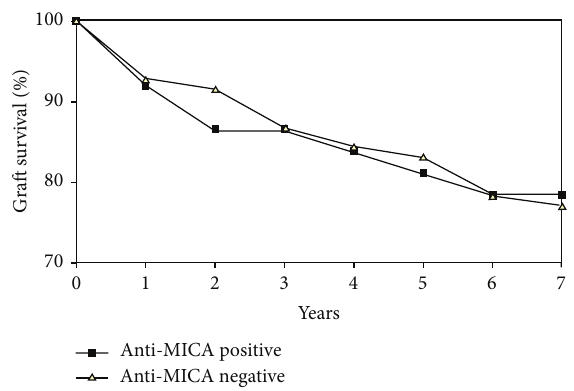
Figure 3: Survival of patients in anti-MICA positive and anti-MICA negative groups. Graft loss occurred in 8 patients in anti-MICA positive group (22%) and 19 (23%) in anti-MICA negative group ( 𝑃 = 0.86 , OR = 1.03